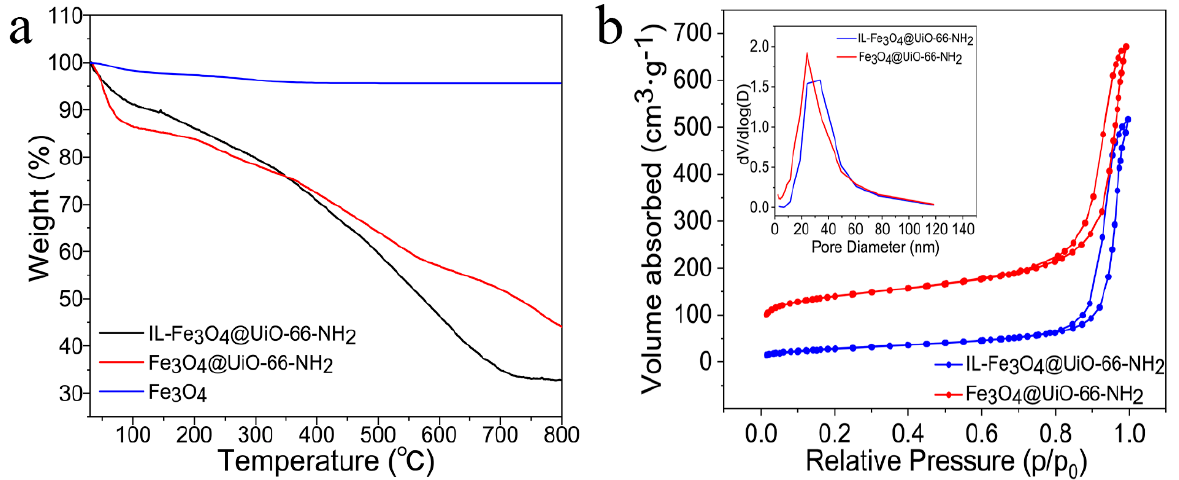
Figure 4. ( a ) TGA curves of the supports; ( b ) N 2 adsorption-desorption isotherms of Fe 3 O 4 @UiO-66-NH 2 and IL-Fe 3 O 4 @UiO-66-NH 2 and pore size distribution curves of Fe 3 O 4 @UiO-66-NH 2 and IL-Fe 3 O 4 @UiO-66-NH 2